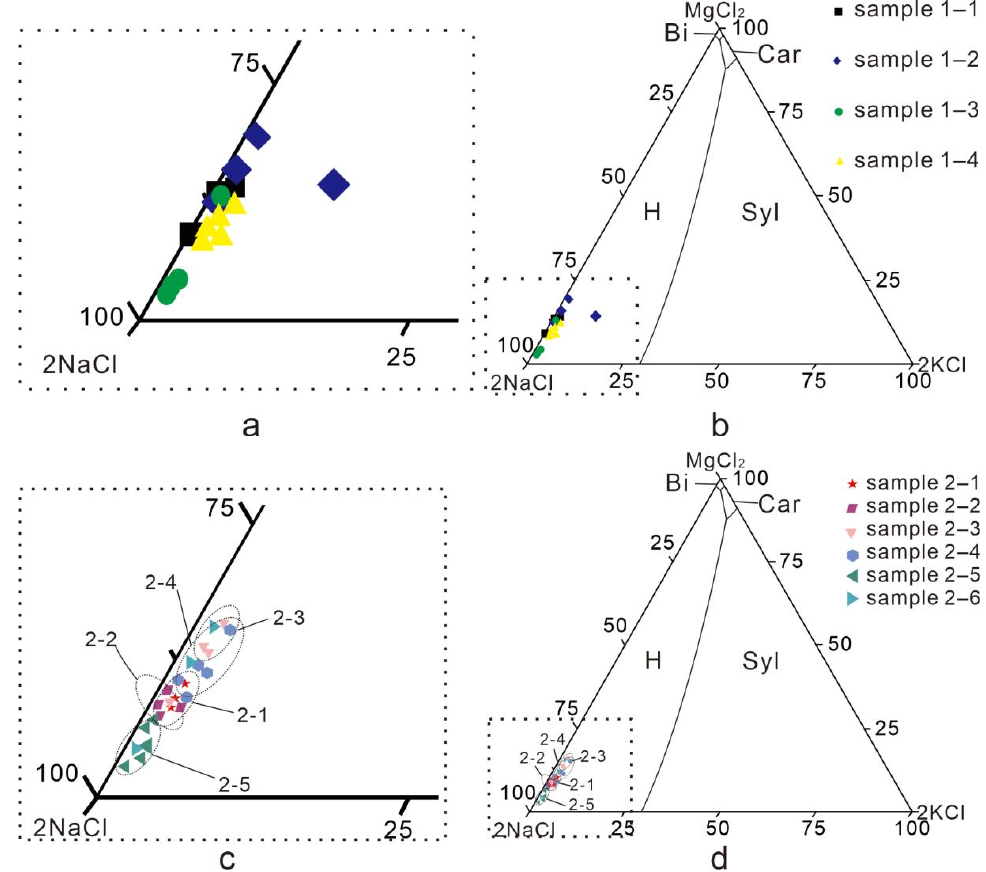
Figure 9. Plot of inclusion composition in phase diagram. H = halite; Car = carnallite; Syl = sylvinite; Bi = bischofite. a and b are the NaCl-KCl-MgCl-H 2 O quaternion phase diagrams of sample 1, ( a ) indicates the local amplification of ( b ); ( c , d ) are the NaCl-KCl-MgCl-H 2 O quaternion phase diagrams of sample 2, ( c ) indicates the local amplification of ( d ).